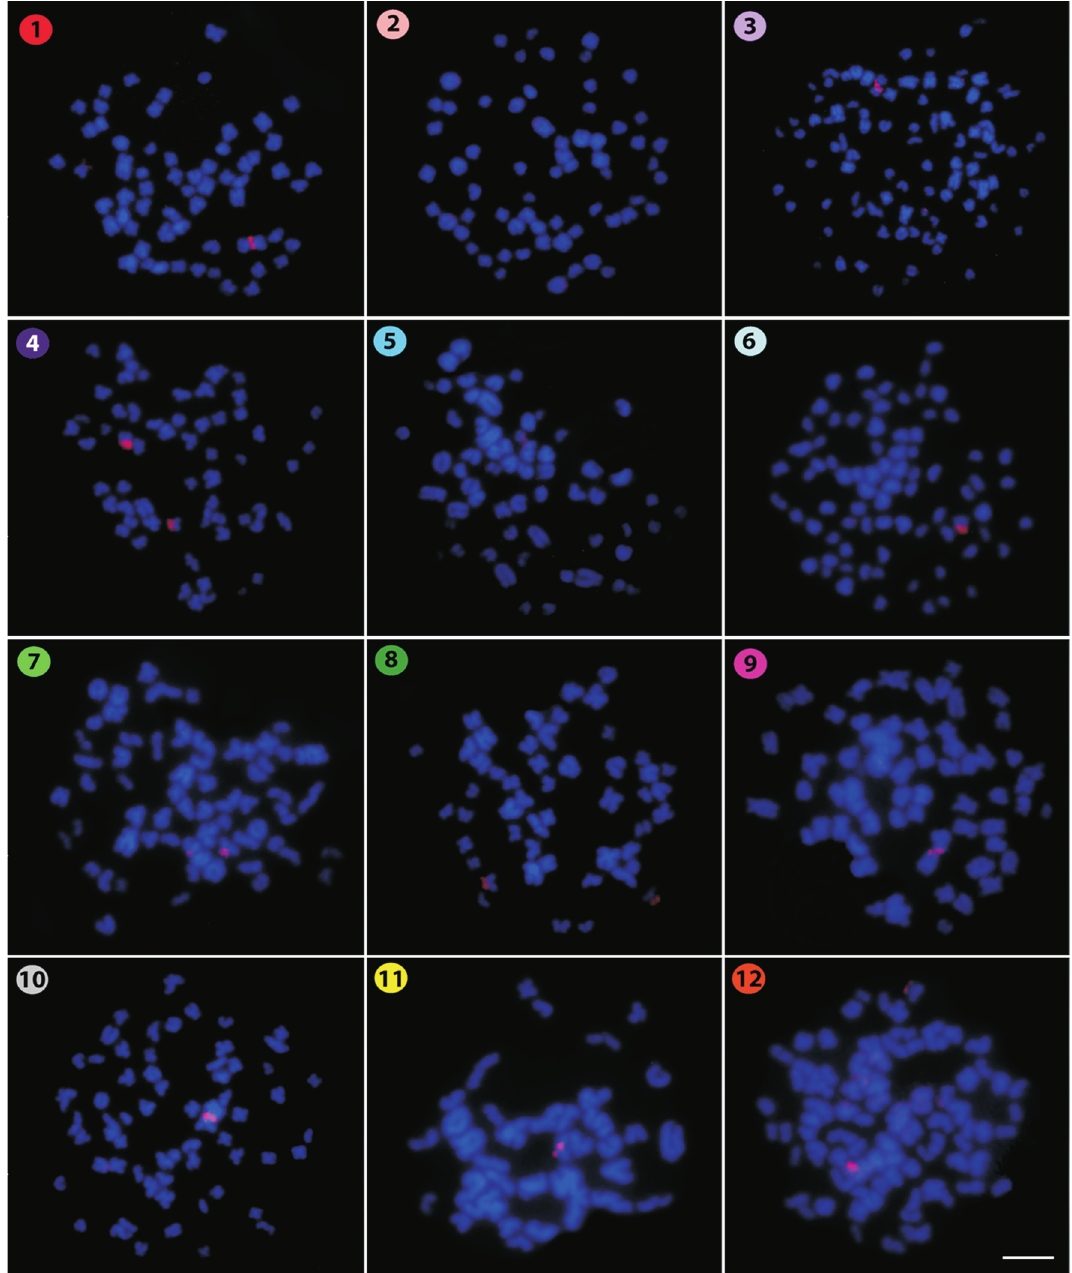
Figure6 -Hybridizationpatternofthe(CGG) 10 microsatelliteprobe(inred)onmetaphaseplatesof Belodontichthystruncates ( 1 ); Kryptopterusbicirrhis ( 2 ); Kryptopterusgeminus ( 3 ); Kryptopteruslimpok ( 4 ); Kryptopterusmacrocephalus ( 5 ); Micronemachevevi ( 6 ); Ompokfumidus ( 7 ); Ompoksiluroides ( 8 ); Phalacronotus apogon ( 9 ); Phalacronotus bleekeri ( 10 ); Silurichthys phaiosoma ( 11 ) and Wallago attu ( 12 ). Scale bar = 5 (cid:2)